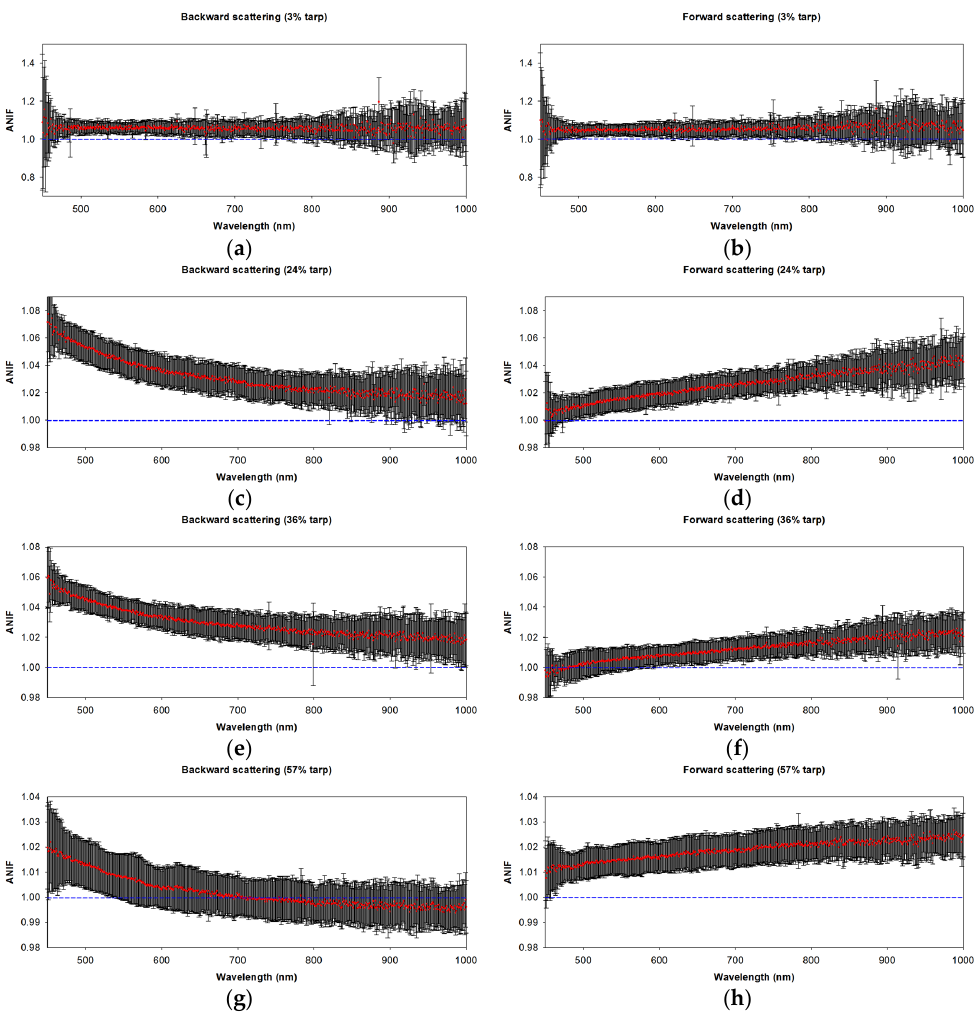
Figure 4. Measured ANIF values (red points) of KOMPSAT-3 for the Goheung field campaign sites. The uncertainty of BRDF measurement is shown by the vertical error bar and the blue dashed line means that no BRDF effect is expected due to an ANIF value of 1. ( a , c , e , g ) show ANIF values of 3%, 24%, 36%, and 57% tarp under backward scattering conditions, and ( b , d , f , h ) show the same values under forward scattering conditions.